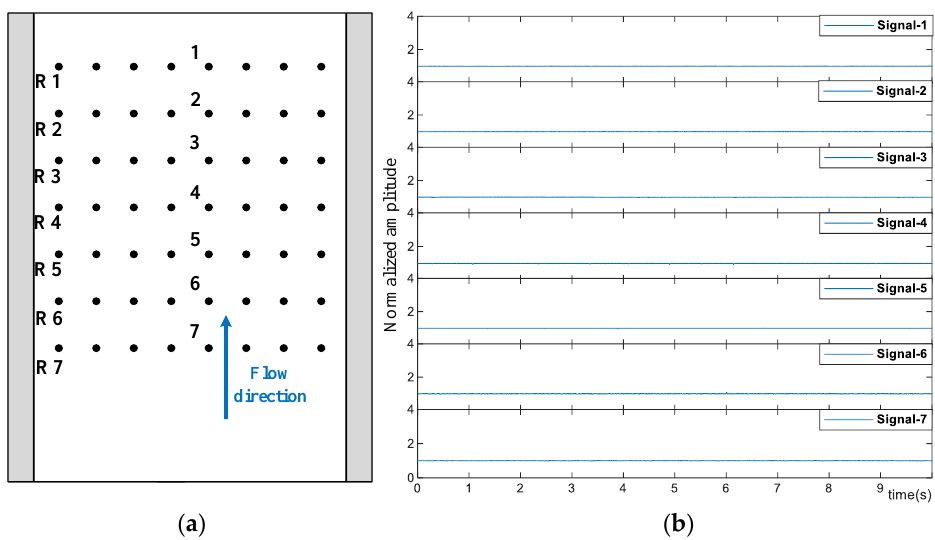
Figure 9. The selected optical fibers ( a ) and their optical signals ( b ) with a heating temperature of 90 °C.